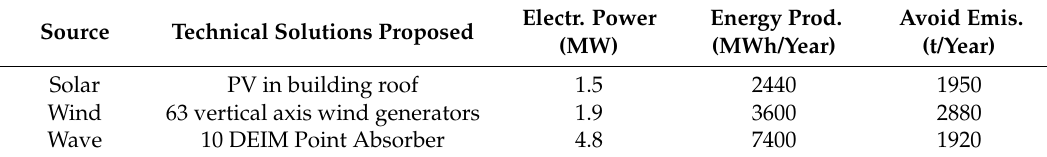
Table 8. Renewable energy system in Pantelleria.